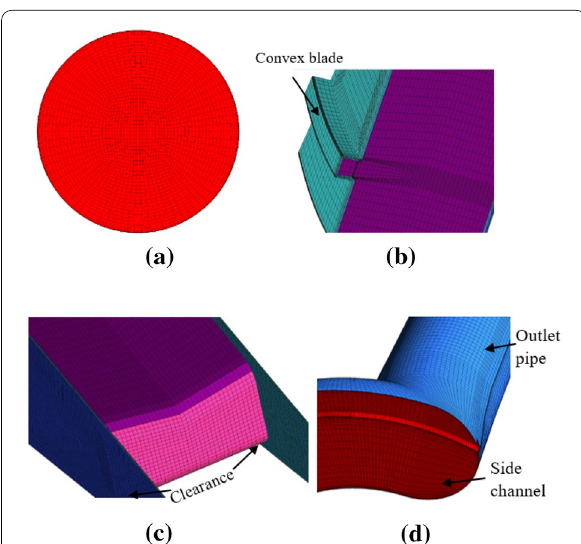
Figure 2 Mesh domains ( a ) inlet, ( b ) impeller, ( c ) hub of impeller, ( d ) side channel